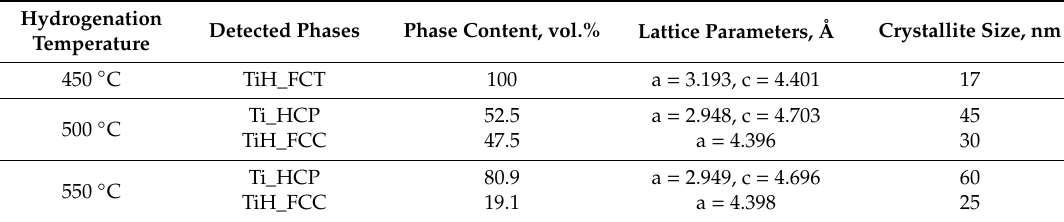
Table 4. Structural parameters of the 80 µ m Ti coating after hydrogenation.